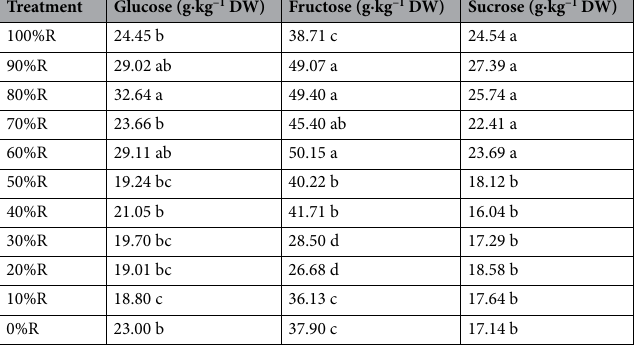
Table 3. The contents of glucose, fructose and sucrose in lettuce at harvest (49DAS). Values for the same parameter with different letters significantly differ at the 5% level (by Tukey’s test, n = 3).